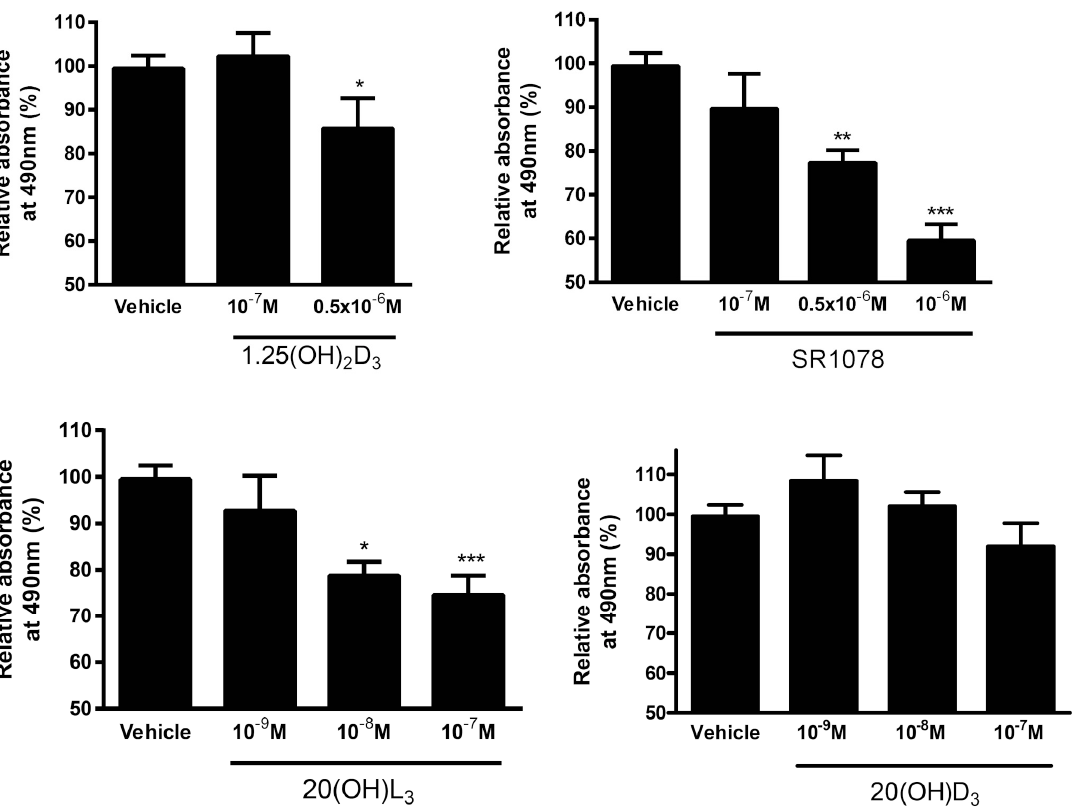
Figure 8. Effect of 1,25(OH)2D3, 20(OH)D3, 20(OH)L 3 , and SR1078 on proliferation of OVCAR3 ovarian cancer cell line as assayed with MTS test ( n = 3). Data are presented as a percentage of the control. Statistically significant differences are denoted with asterisks as determined by ANOVA (* p < 0.05, ** p < 0.01, and *** p < 0.001).